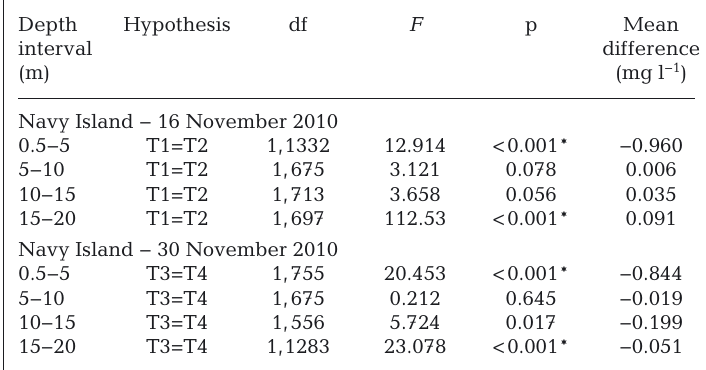
Table 1. Welch ANOVA test results of mean concentrations of total sus- pended particulate matter (mg l −1 ) between sampling transects at the Navy Island salmon farm on 16 and 30 November 2010. The location of each transect (T1 to T4) is shown in Fig. 3A,B and ANOVA comparisons are for the indicated transects and depth ranges. *Significant at α =